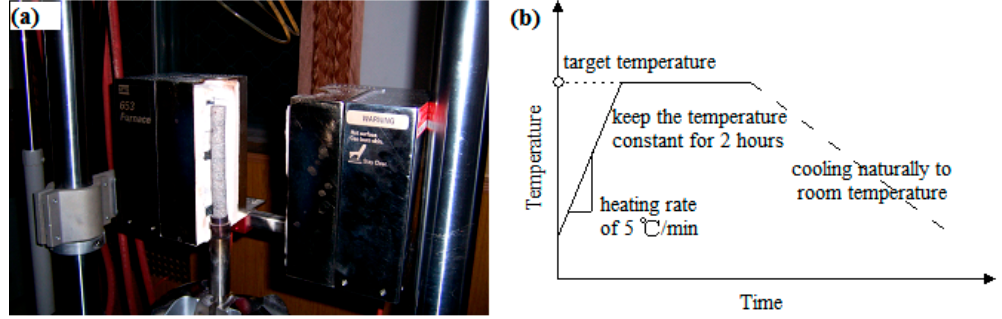
Figure 2. Heating device and procedure for thermal treatment. ( a ) The high temperature furnace MTS653; ( b ) the heating